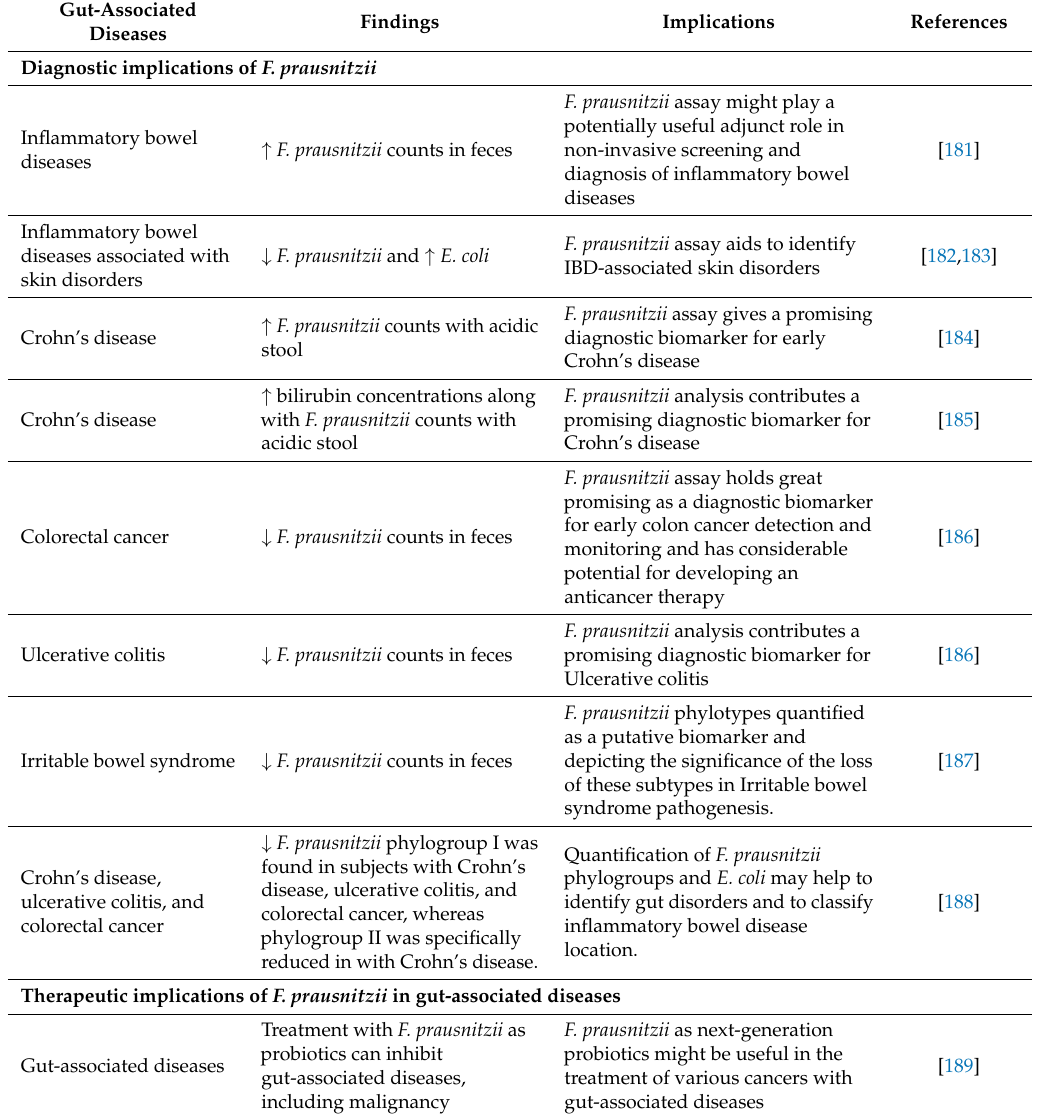
Table 3. Diagnostic and therapeutic implications of F. prausnitzii on various gut-associated